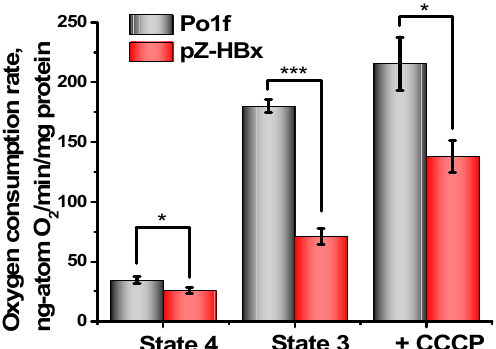
Figure 5. Oxygen consumption rates by Y. lipolytica mitochondria in states 3 and 4, and uncoupled states. When indicated, 2 µ M CCCP was added. The statistical analyses were carried out by the one-way ANOVA test. ***: p < 0.001; *: 0.01 < p < 0.05.